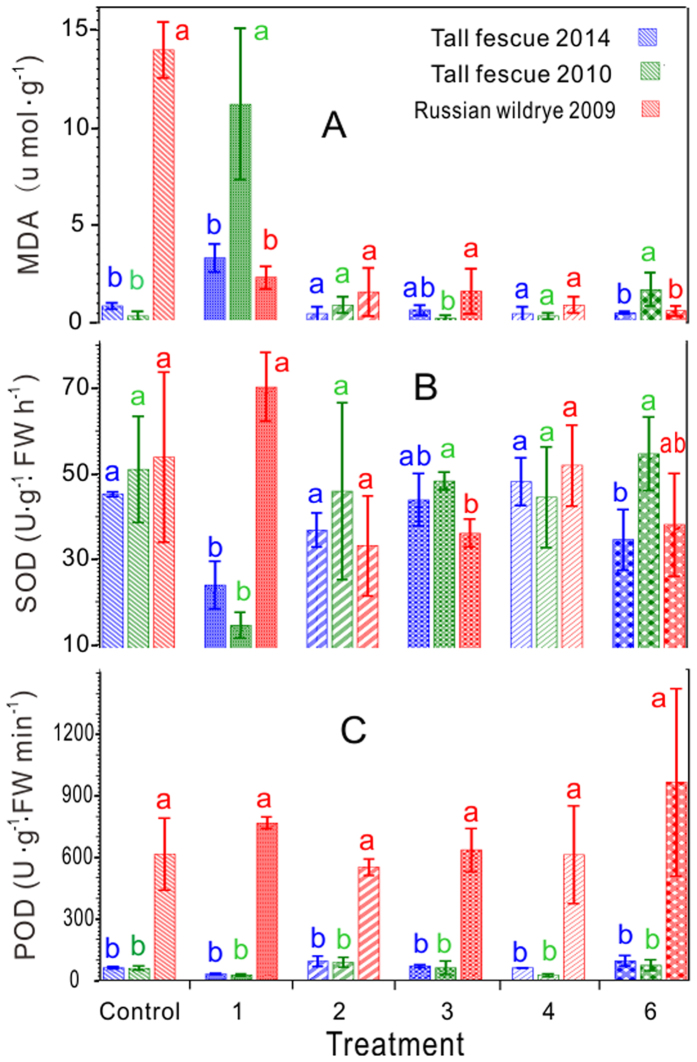
MDA content (A) and activity of SOD (B) and POD (C) in the seedlings of tall fescue (2014 and 2010) and Russian wild rye (2009). The letters indicate differences only within the treatments among the different years. FW is the fresh weight.